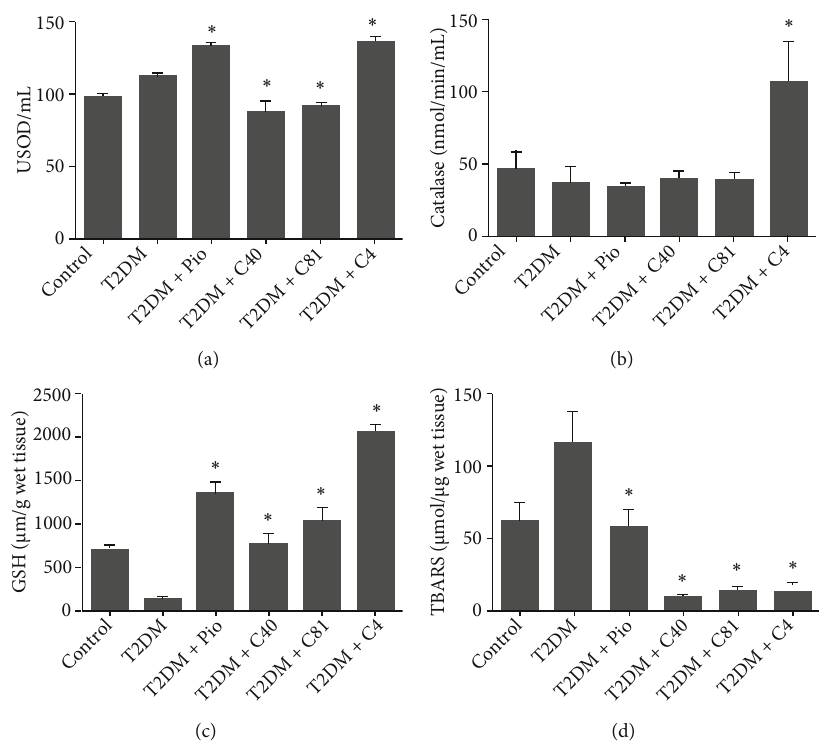
Figure 3: Enzymatic and nonenzymatic antioxidant activity in the di ff erent groups ( n = 7 ): (a) SOD (U/mL), (b) CAT (nmol/min/mL), (c) GSH ( μ M/g of wet tissue), and (d) TBARS ( μ mol/ μ g of wet tissue). ∗ p ≤ 0 : 01 vs. T2DM (the untreated diabetic rats). Pio: